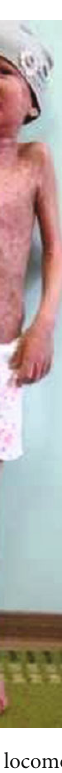
Figure 4: The child regained her locomotor capability through standing and walking. She started to walk with the support of the hand with the fi xation of the lower extremities in the knee-ankle- foot orthoses. The mobility of the knee joints approached to somehow convincing results. Full extension, feet in the middle position, and with support of the entire plantar surface of the feet have been approached